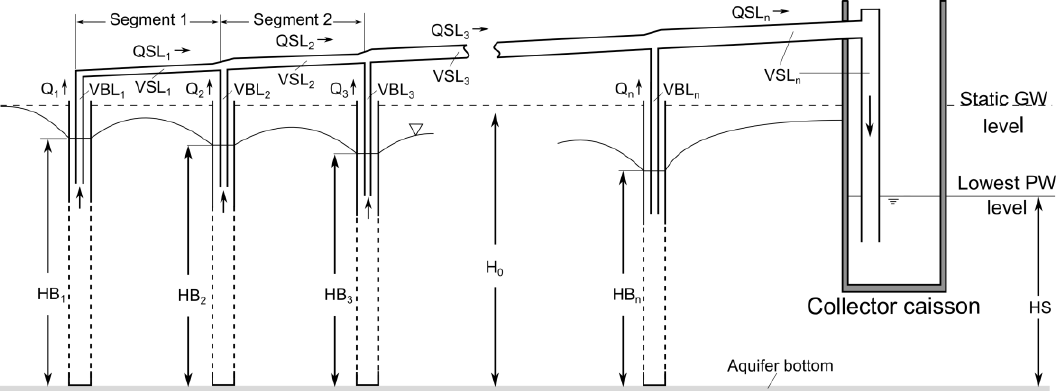
Figure 2. Schematic of the hydraulic calculation parameters.